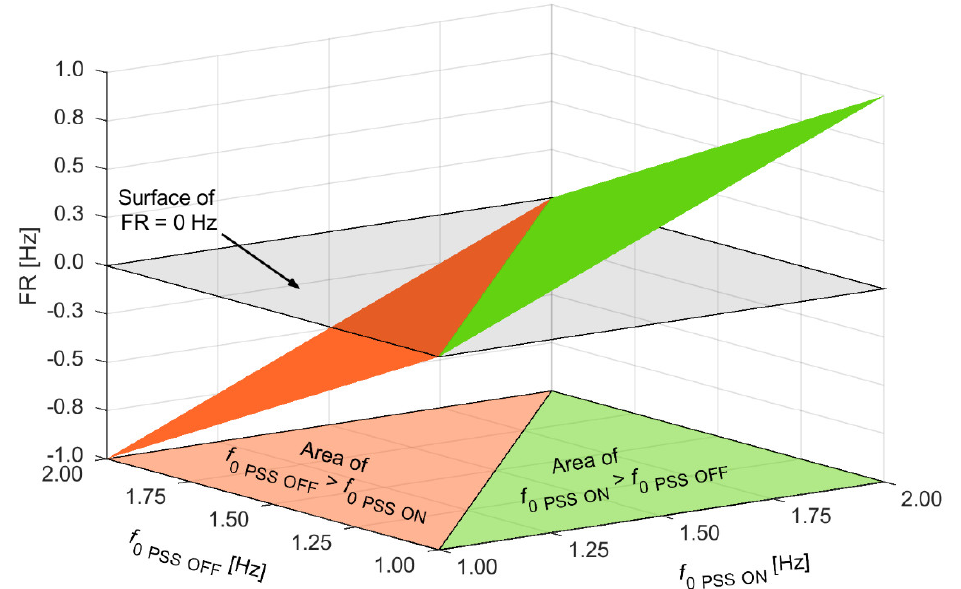
Figure 19. 3D graphical presentation of the FR index plotted on the f 0 PSS ON - f 0 PSS OFF plane (general relation).